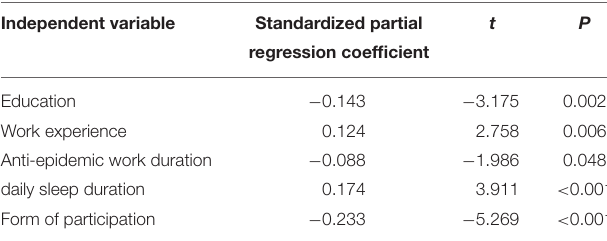
TABLE 5 | Multivariate analysis of the job satisfaction of frontline medical staff ( n =